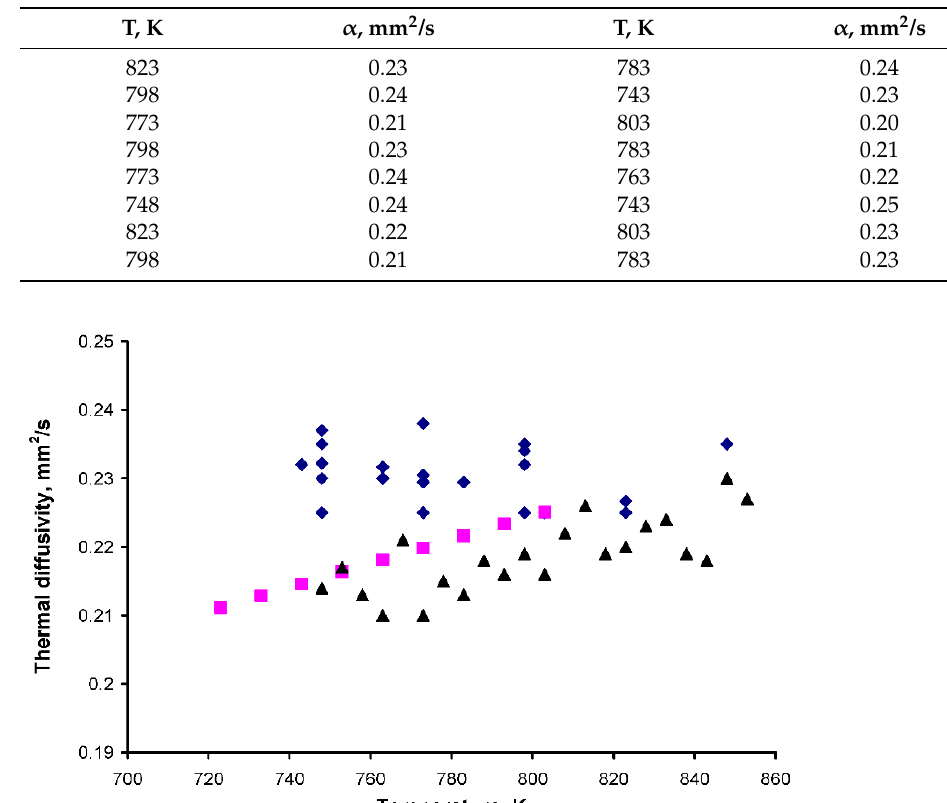
Table 2. Results of thermal diffusivity measurements of FLiNaK.